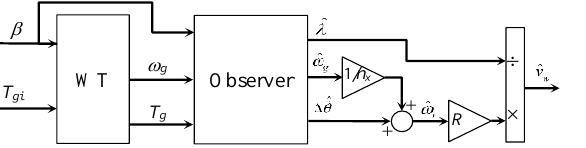
Figure 2. Observer configuration for the estimation of state variables and effective wind speed.